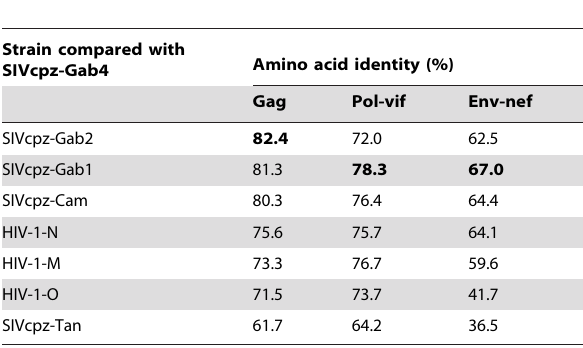
Table 2. Protein sequence identities among SIVcpz/HIV-1